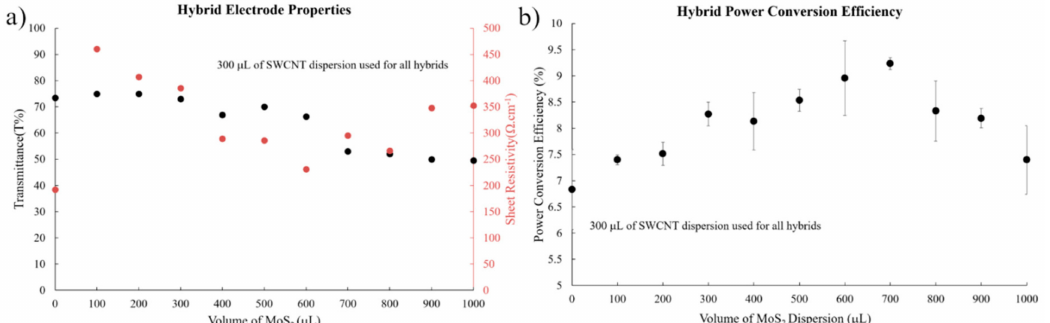
Figure 4. ( a ) Electrode properties for films of di ff erent ratios of SWCNT and MoS 2 dispersions; ( b ) E ffi ciencies of solar cells with films made with di ff erent ratios of SWCNT and MoS 2